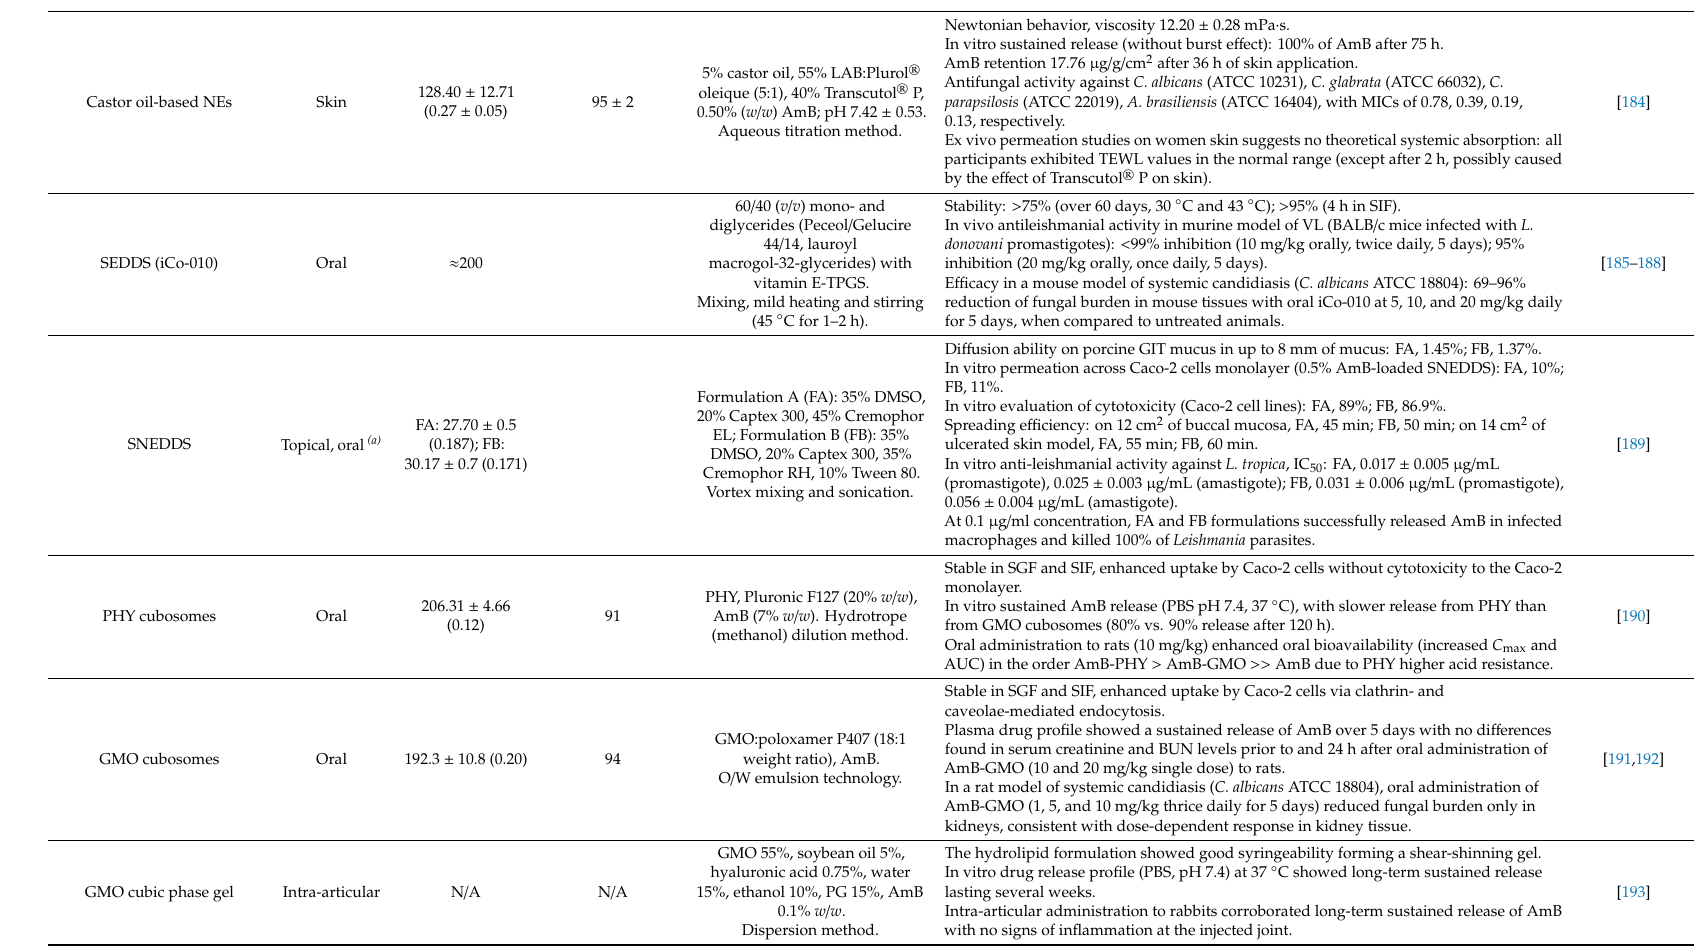
Castor oil-based NEs Skin 128.40